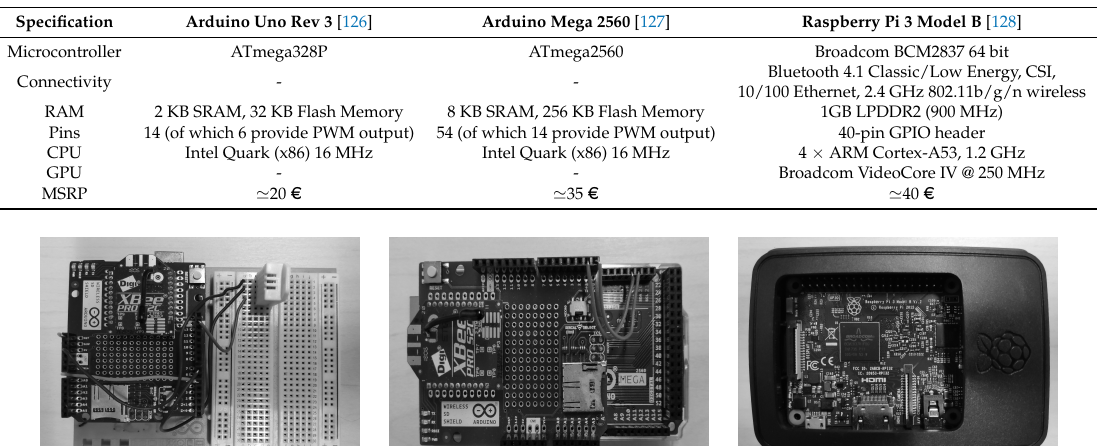
Table A1. Technical specifications of the devices used in this paper for the realization of the WSNs and fog computing network.